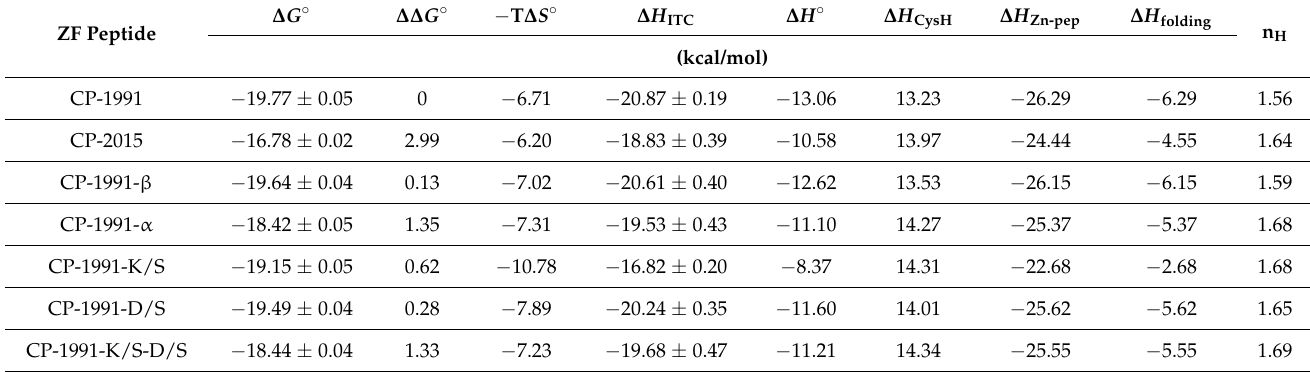
Table 2. Enthalpy and entropy parameters of Zn(II)-to-ZF peptide binding derived from ITC